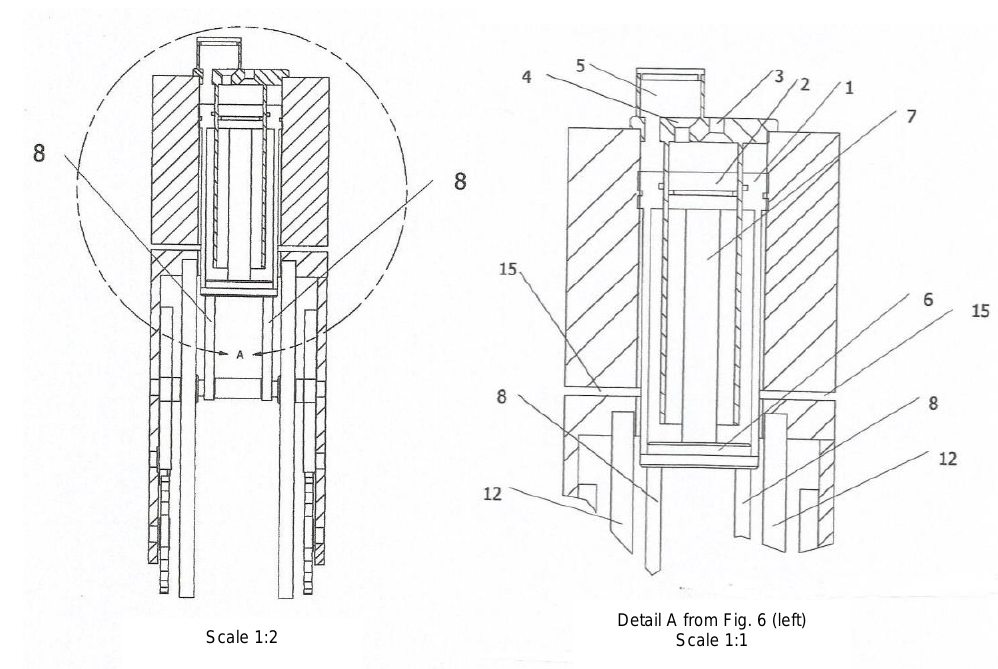
Fig. 6. Engine details of an internal combustion without a crankshaft